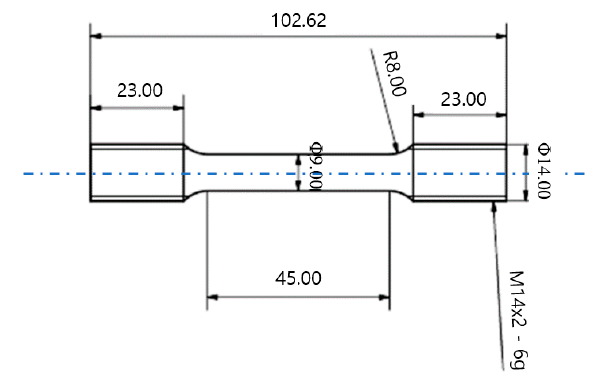
Figure 3. Specimen configuration for tensile test.